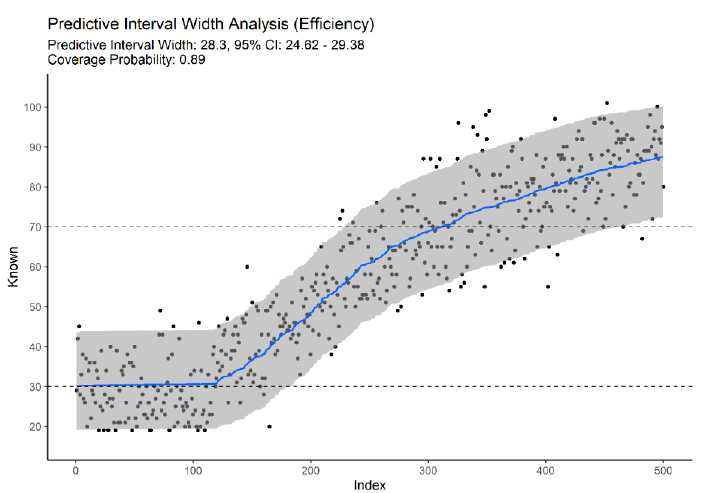
Biology 2022 , 11 , x FOR PEER REVIEW 18 of 32 Figure 4. Predictive efficiency of degenerative traits of the axial and appendicular skeleton, α = 0.1.